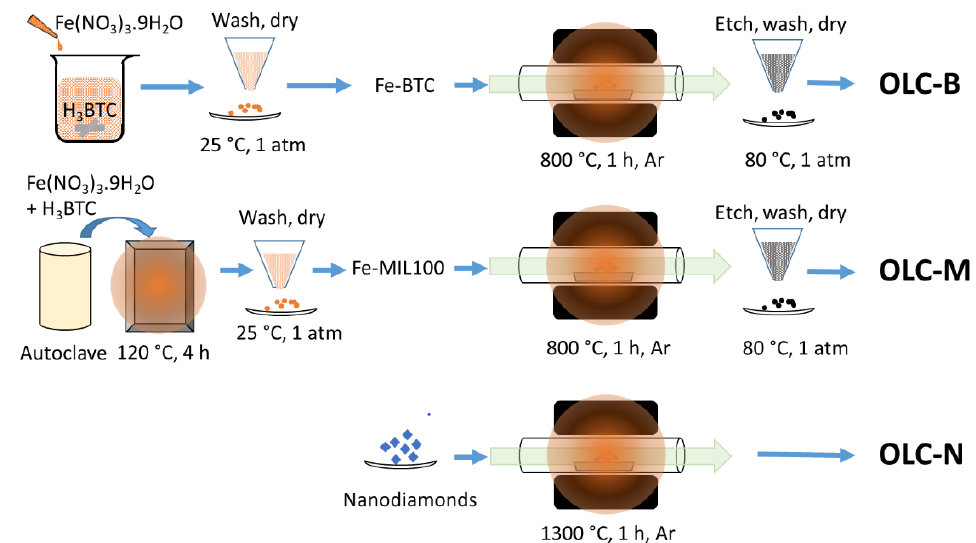
Figure 1. Schematic representation of synthesis processes for OLC-B, OLC-M, and OLC-N.